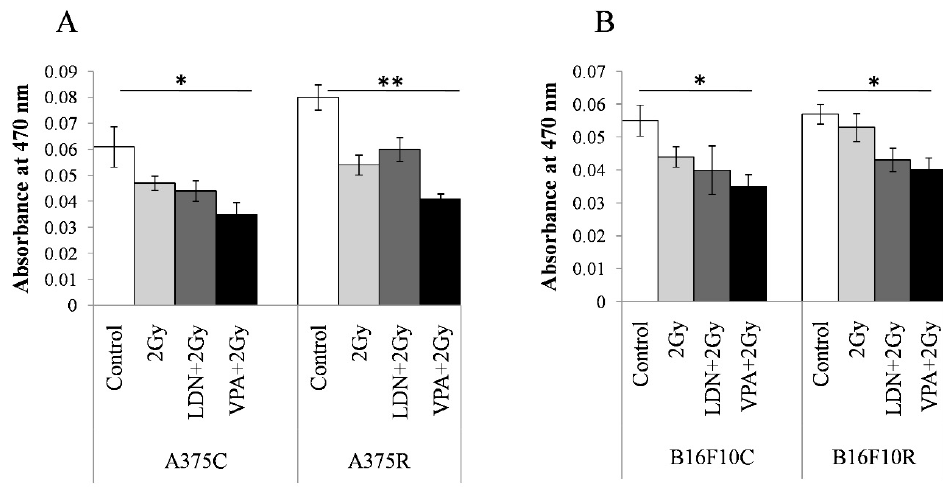
Figure 5. Content in the resistant cells sensitized with VPA/LDN193189 before radiation. Cells were pretreated with IC 25 dose of VPA or LDN193189 and were irradiated. After 24 h of incubation, the flask containing cells were irradiated with gamma radiation (GC-5000, BRIT Mumbai) at the CARRT, Mangalore University, at a dose rate of 8.8 Gy/min for 14 s (equivalent to 2 Gy) at room temperature and cells were further incubated with drugs for 24 h. Following incubation, cells were lysed and the color due to melanin release was measured at 470 nm. Respective sham irradiation and control (untreated) groups were used for comparison and data shown are mean ± standard deviation (SD) of three replicate wells. ( A ) shows the results on human melanoma A375and ( B ) shows the results on mouse melanoma B16F10. * p > 0.05, ** p > 0.001.